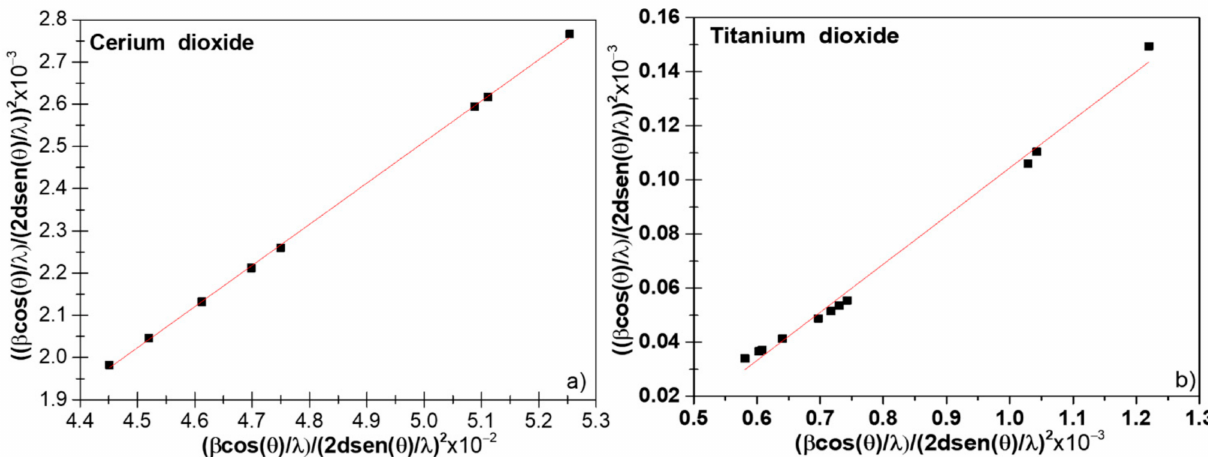
Figure 4. Halder–Wagner (H–W) plot of CeO 2 ( a ) and TiO 2 ( b